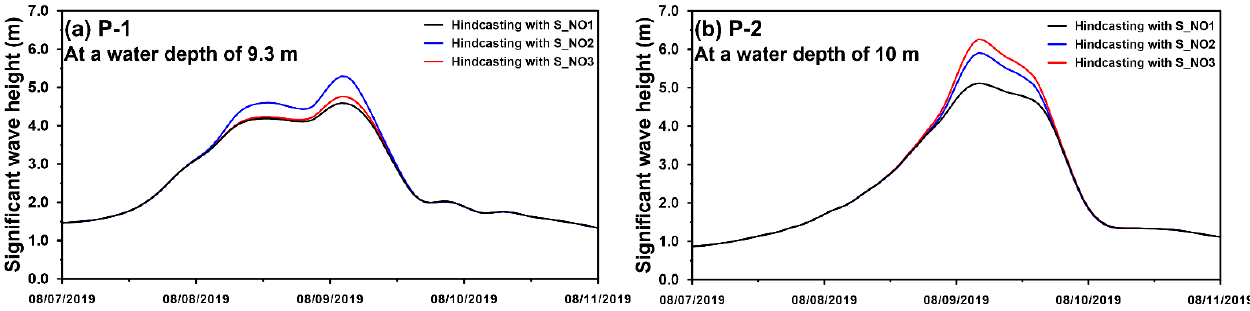
Figure 12. Time series of hindcasted SWHs for ( a ) P1 and ( b ) P2 using the S_NO1, S_NO2 and S_NO3 scenarios during the passage of Super Typhoon Lekima in 2019. passage of Super Typhoon Lekima in